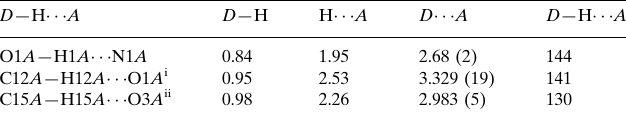
Hydrogen-bond geometry (A˚ , (cid:2)